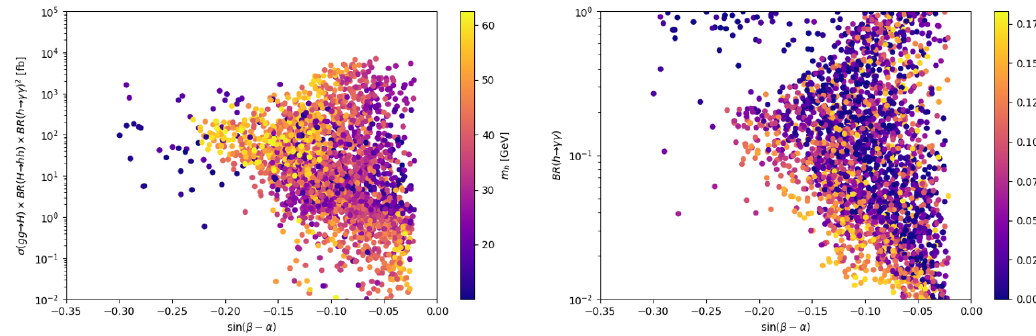
Figure 4. (Left) The (cid:27) 4 (cid:13) rate as a function of sin( (cid:12) (cid:0) (cid:11) ) with m h indicated on the right vertical axis. (Right) The BR( h ! (cid:13)(cid:13) ) as a function of sin( (cid:12) (cid:0) (cid:11) ) with BR( H ! hh ) indicated on the right vertical axis. Both plots are for